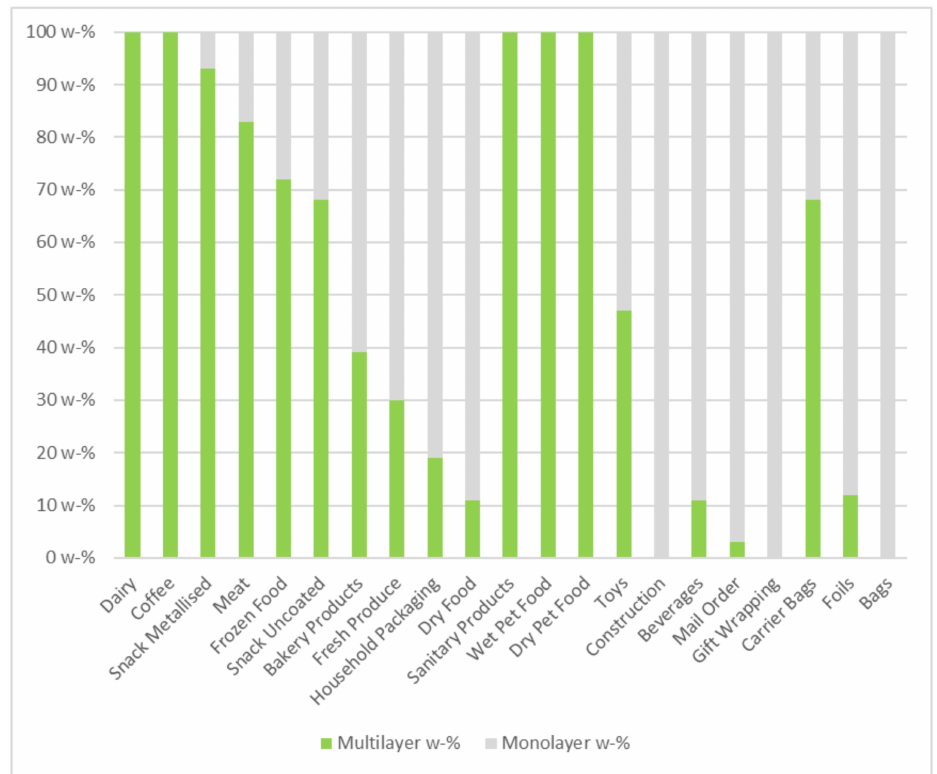
Figure 6. Percentage of monolayer- and multilayer materials in typical applications for small films.